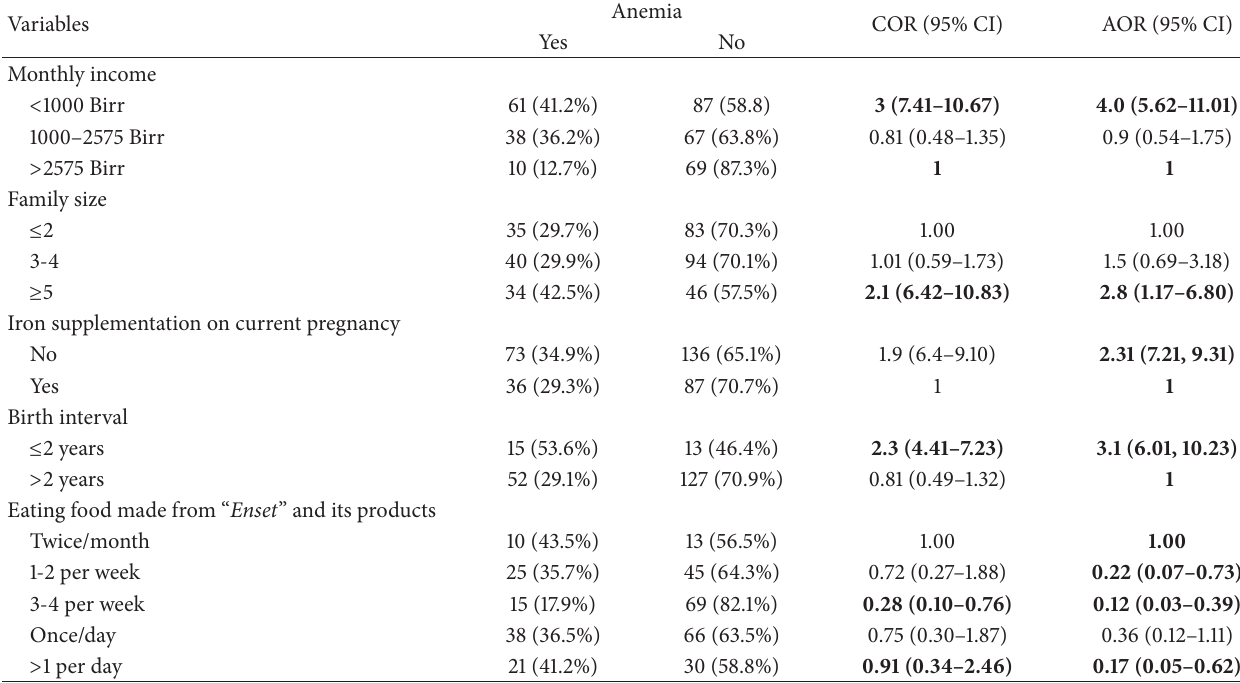
Table 7: Multivariate logistic regression analysis results showing factors associated with anemia in pregnancy among ANC attendees in government health institutions of Arba Minch town from February to April 2015 ( 𝑛 = 332